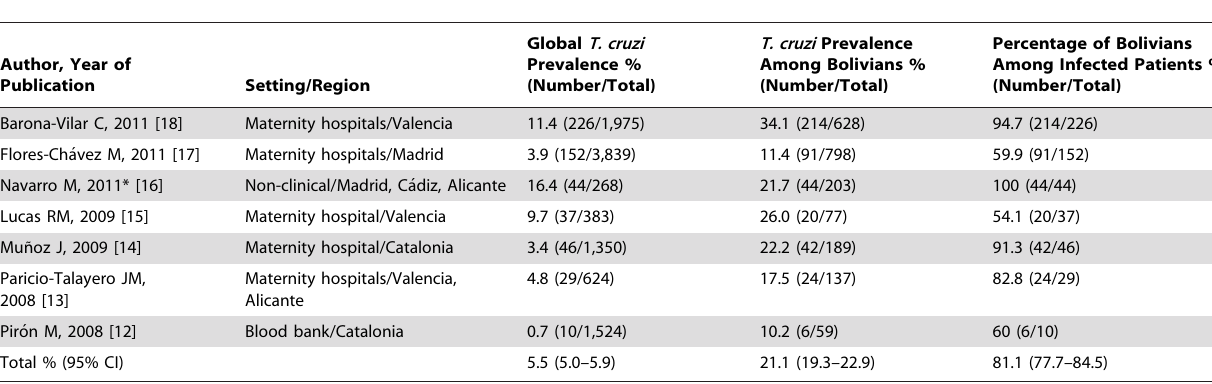
Table 1. Seroprevalence of T. cruzi infection among adult migrants (aged over 17) in Spain